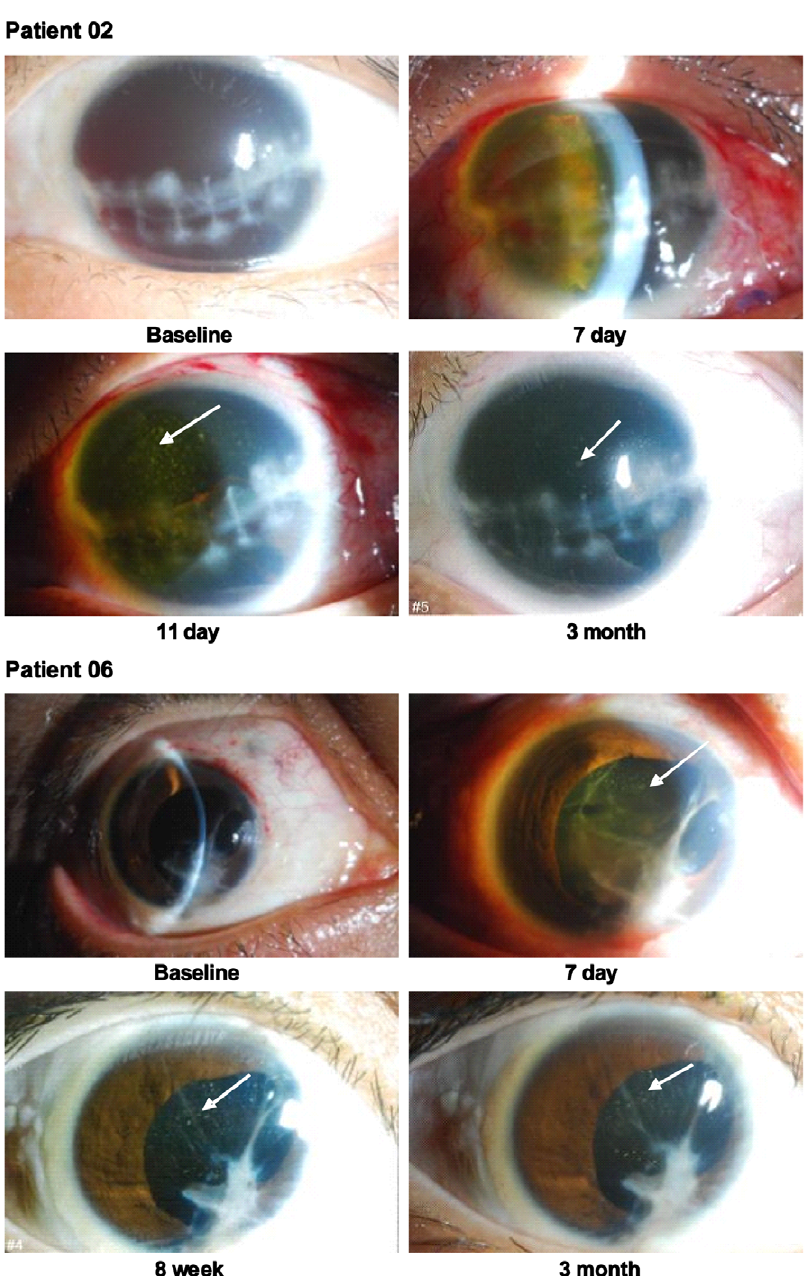
Figure 2. Anterior segment status of FCVB-filled eyes at baseline and at FCVB implantation. Patient 02 and 06 both suffered from severe ocular injury. Patient 02 had a marked hyphema and exudation in the anterior chamber in the first week after FCVB implantation. At the 11th day, a few point-like opacities (white arrow) were found in the intra-FCVB fluid and these opacities persisted until the 3th month. Patient 06 also had a few point-like opacities in the intra-FCVB fluid in the 7th day, and these opacities was persisted until the 3th month. However, no anterior segment inflammation (conjunctival chemosis, corneal edema, keratic precipitates, aqueous flare or aqueous cell) was found in these two patients after three months.